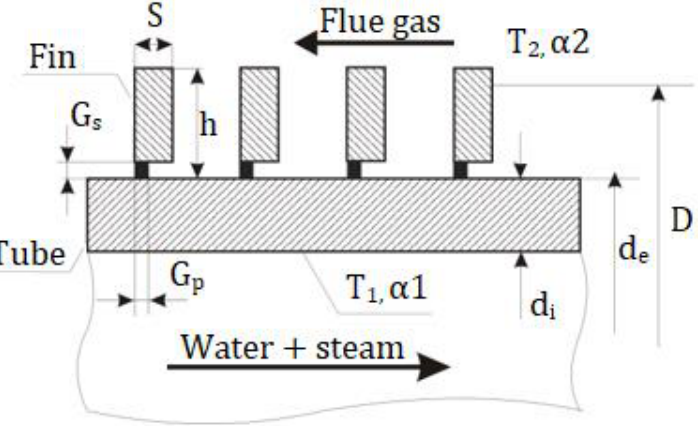
Figure 13. Diagram of a tube/fin joint with incomplete penetration [28].